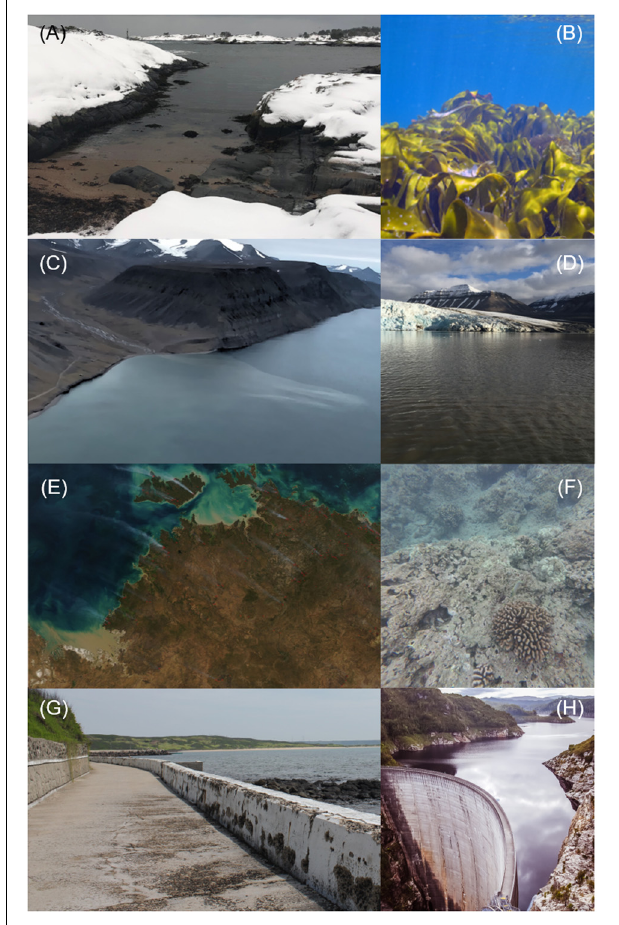
FIGURE 1 | Examples of altered ter-OM loads to coastal ecosystems in (A,B) the boreal zone, due to increased precipitation with potential effects on kelp forests (Skagerrak, Norway), (C,D) the arctic zone, due to thawing permafrost and melting glaciers (Longyearbyen, Spitzbergen), (E,F) tropical zones, due to episodic extreme events with potential effects on e.g., coral reefs (Australia), and (G,H) global coastal zones due to direct human impacts on land-ocean interactions, such as structural modifications of shorelines (Pescadores Islands, Taiwan), or dam construction (Gordon Dam, Australia). Photo courtesy: ( A,C,D,F,G ) A. Deininger, (B) J. Gitmark, (E) J. Schmaltz (NASA), and (H) L.